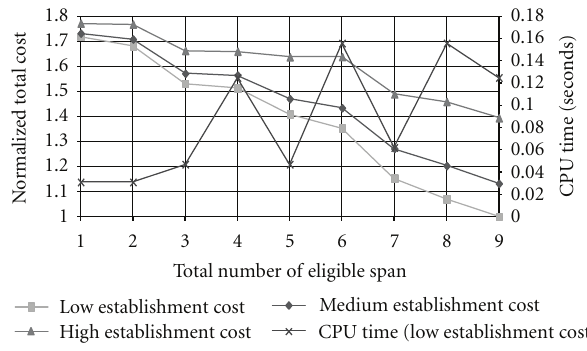
Figure 4: Total network costs and CPU time versus the number of eligible spans for the 20-node network.